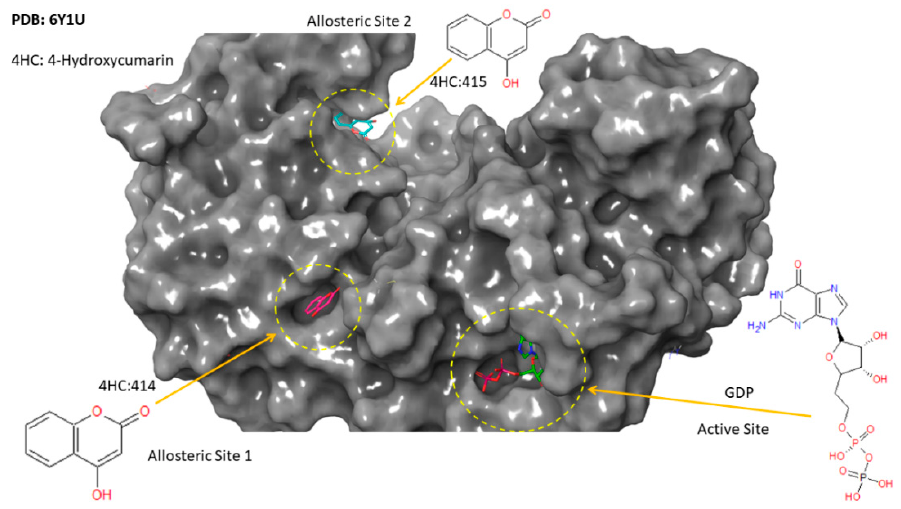
Figure 6. Surface view structure of FtsZ in complex with GDP nucleotide moiety in the active site and 4-hydroxycumarin ligand in two allosteric sites studied by Alnami et al. [26].